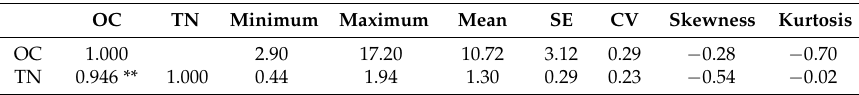
Table 2. Pearson correlation and classical statistics of SOC and TN of the samples ( n = 454) from the cropland